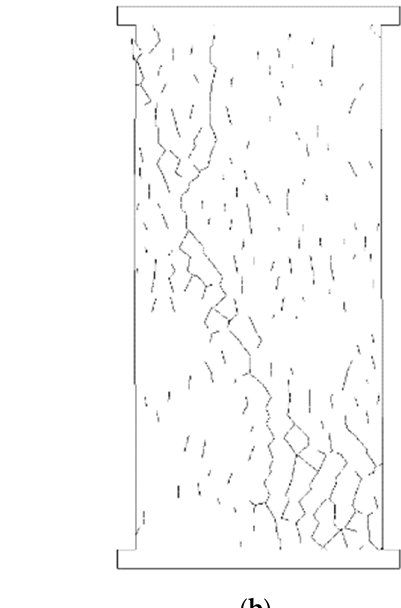
Figure 11. Fraction of contacts with damage levels equal or above 0.1, 0.5, and 0.9 vs. vertical strain.